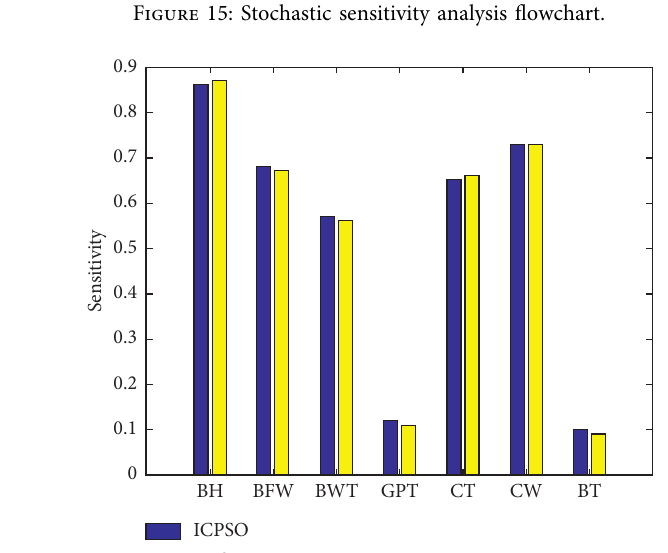
Figure 16: Sensitivity coefficient for 5% variation